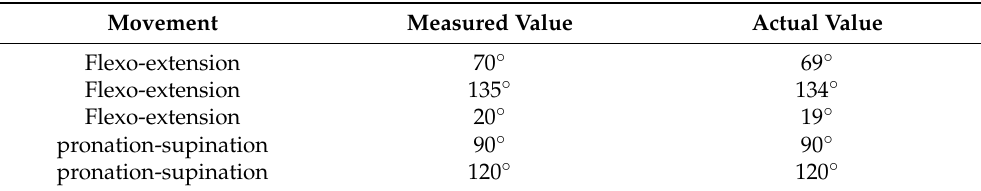
Table 4. Absolute error for the angles of movement measured with the goniometer and the proposed prototype.